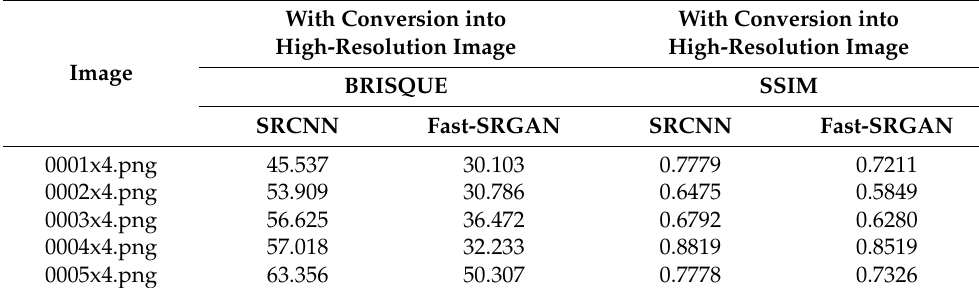
Table 2. BRISQUE, SSIM measuring result: typical image set.